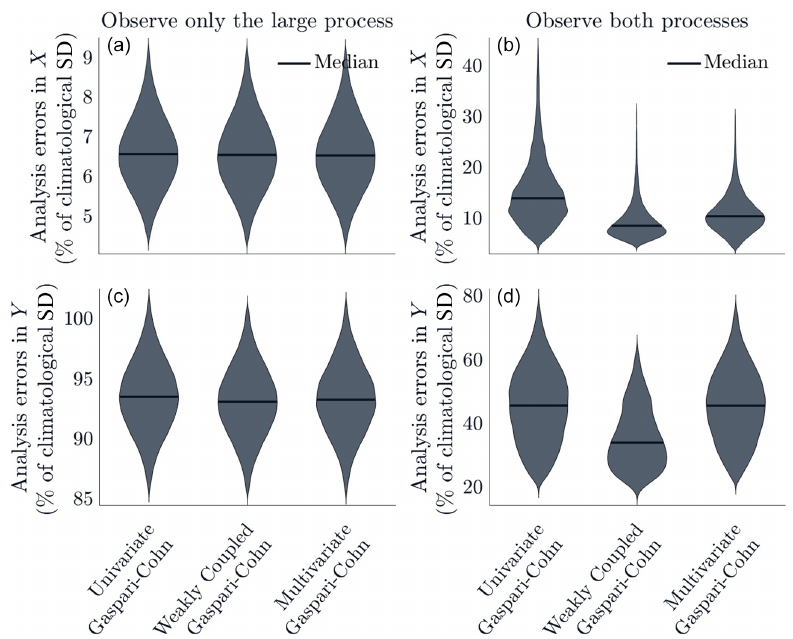
Figure 4. Violin plots show the distribution of analysis errors for all versions of the Gaspari–Cohn localization function (Hoffmann, 2015). Analysis errors are calculated as RMS deviations from the truth and are scaled by the climatological standard deviation of the associated process. (a, c) Results from the experiment where we observe only the large process. All functions perform similarly. (b, d) Results from the experiment where we observe both processes. The weakly coupled localization functions appear to lead to the best performance but are highly